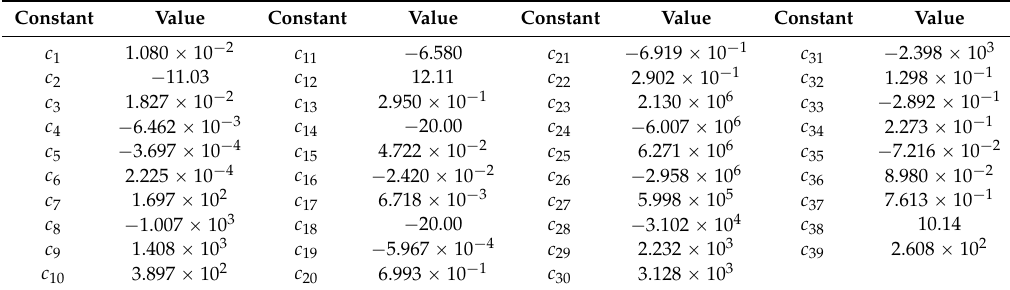
Table 5. Constants values of Equations (14)–(18).